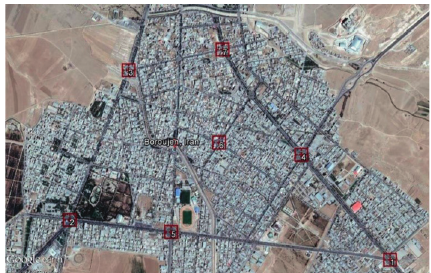
Figure 18: Geographical location of Gorgan.